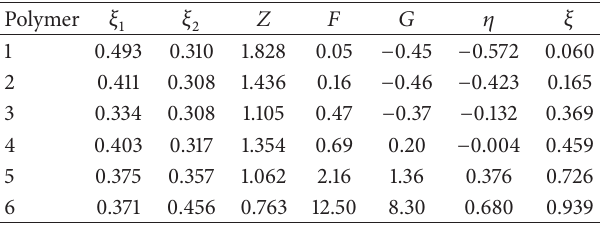
Table 3: Extended KT parameters for APMA-co-EMA copolymer system.